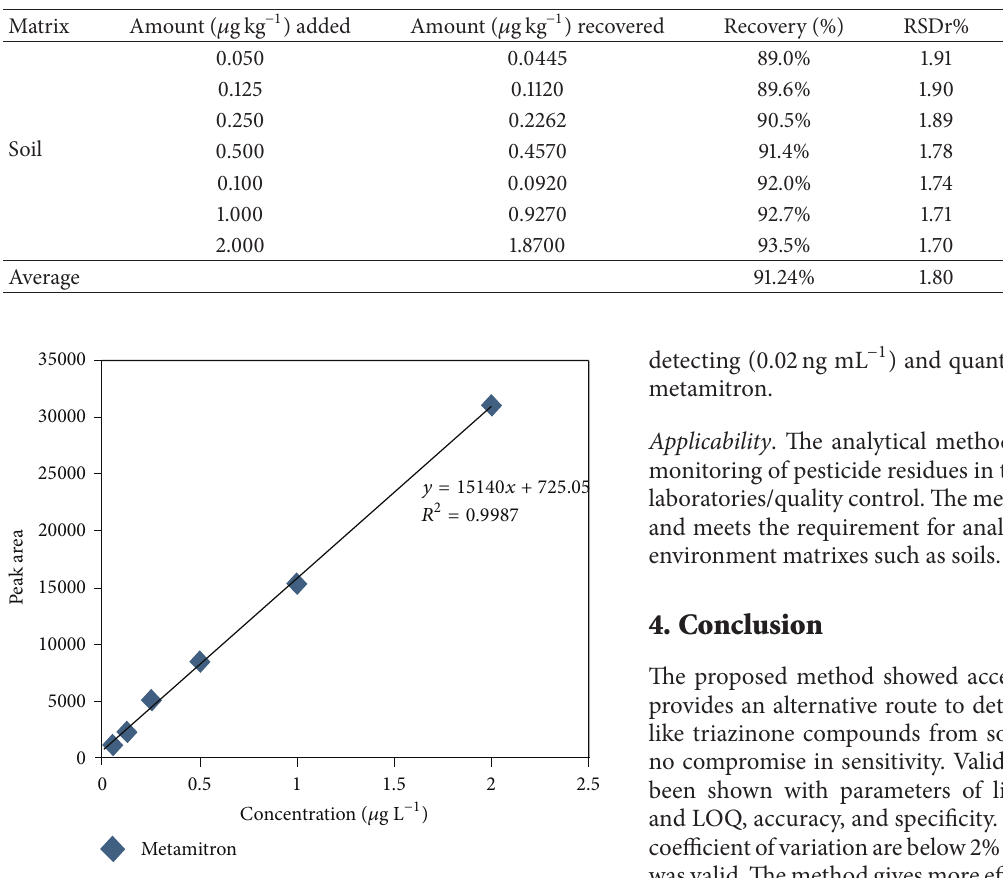
Figure 4: Calibration curve for